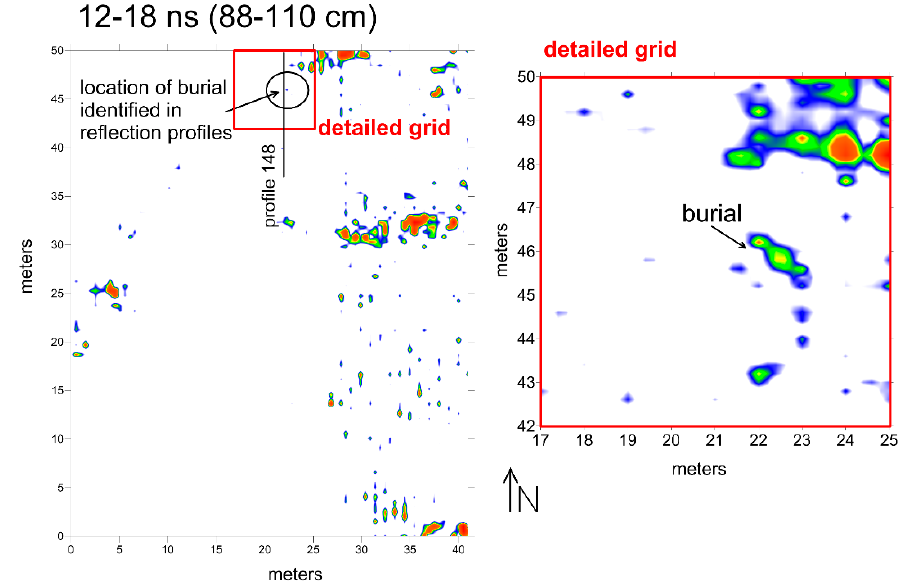
Figure 5. Amplitude slice-map of the 88–110 cm level showing where the burial reflections should be in standard slice-map production, and how re-sampling and gridding of a small detailed area of the grid can show the human-shaped burial reflection in greater detail. Location of file 148 in Figure 6 is shown.